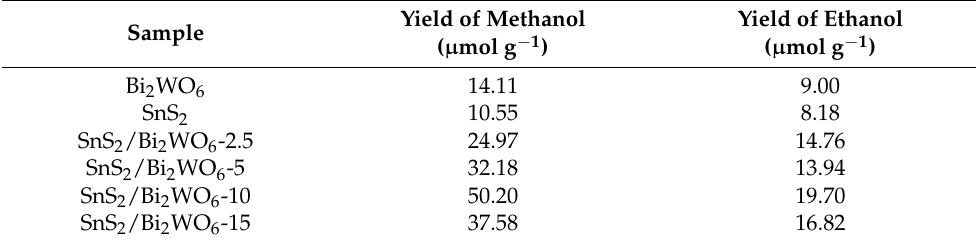
Figure 6. Time dependence of yields of ( a ) methanol and ( b ) ethanol during photoreduction of CO 2 . Table 1. 4 h yield of methanol and ethanol.